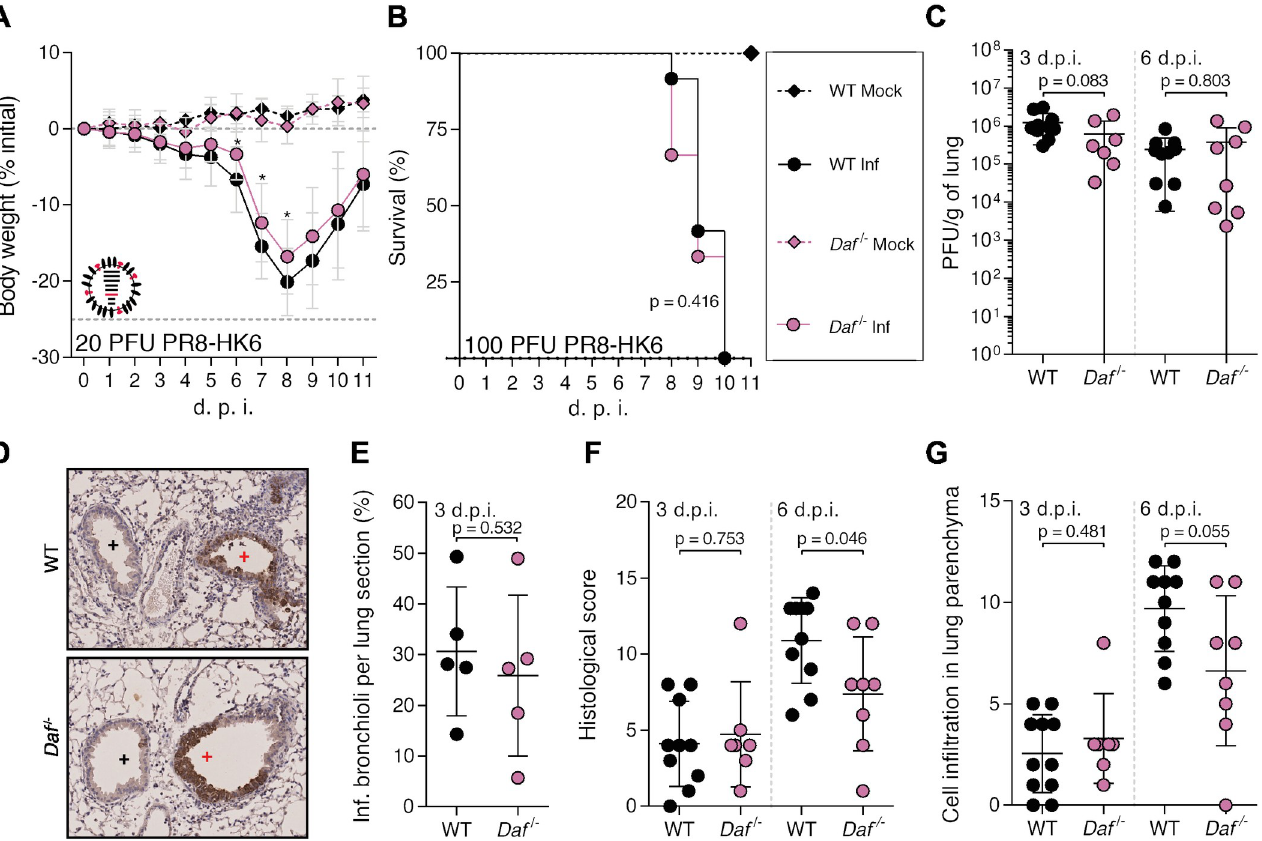
Fig 6. DAF interaction with HA worsens disease outcome, without increasing immunopathology. A, B : Bodyweight loss ( A ) and mortality ( B ) of C57BL/6J WT or Daf -/- mice infected with the indicated doses of A/Puerto Rico/8/1934 with segment 6 from A/Hong Kong/1/68 (PR8-HK6). ( A: Inf n = 16 and n = 18, mock n = 6 and n = 7 for WT and Daf -/- respectively; B: Inf n = 12 and n = 9, mock n = 4 and n = 2 for WT and Daf -/- respectively). Results are expressed as mean ± sd. C : Lung viral titers of C57BL/6J WT or Daf -/- mice infected with 20 PFU of PR8-HK6. Samples collected at 3 and 6 d.p.i. (n = 10 and n = 7 for WT and Daf -/- respectively). D : Immunohistochemistry detection of IAV nucleoprotein (NP) in WT or Daf -/- 3 d.p.i. with 20 PFU of PR8-HK6 (+ healthy; + infected). E : Quantification of infected bronchioli (n = 5 per group). F, G : Histological score and cell infiltration of lung parenchyma of C57BL/6J WT or Daf -/- mice infected with 20 PFU of PR8-HK6. Samples collected at 3 d.p.i. (n = 10 and n = 7 for WT and Daf -/- respectively) and 6 d.p.i. (n = 10 and n = 8 for WT and Daf -/- respectively). Results are expressed as mean ± sd. Statistical analysis detailed in materials and methods.